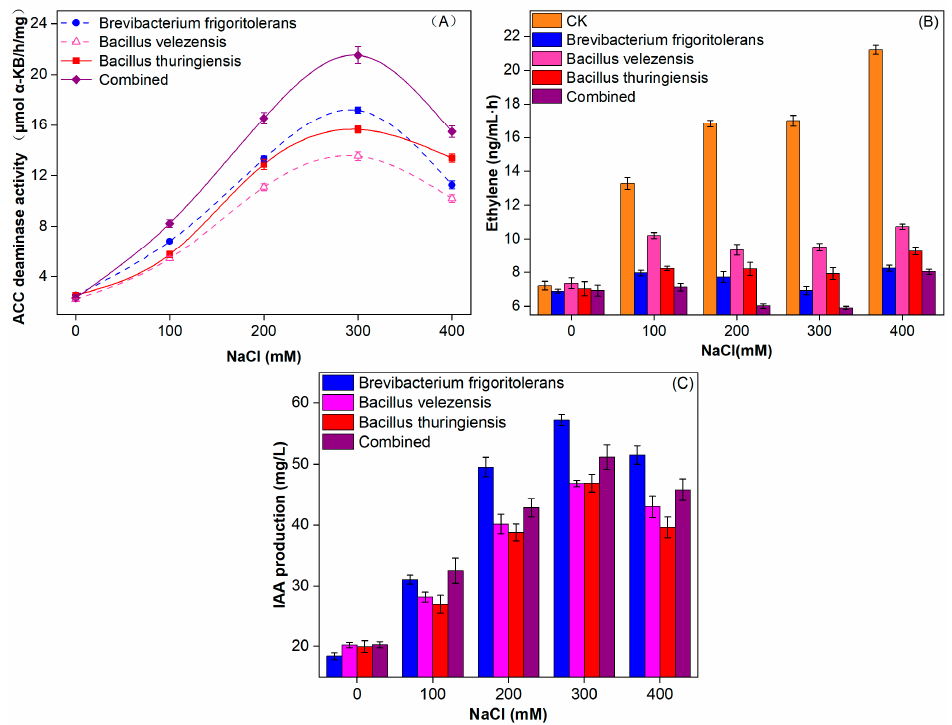
Figure 5. Effects of NaCl stress on ( A ) ACC deaminase activity of salt-tolerant plant growth promoting rhizobacteria (ST-PGPR), ( B ) ethylene levels in wheat, and ( C ) indole-3-acetic-acid (IAA) production of ST ‐ PGPR. Table 1. Effect of NaCl on amino acid excreted by wheat root.